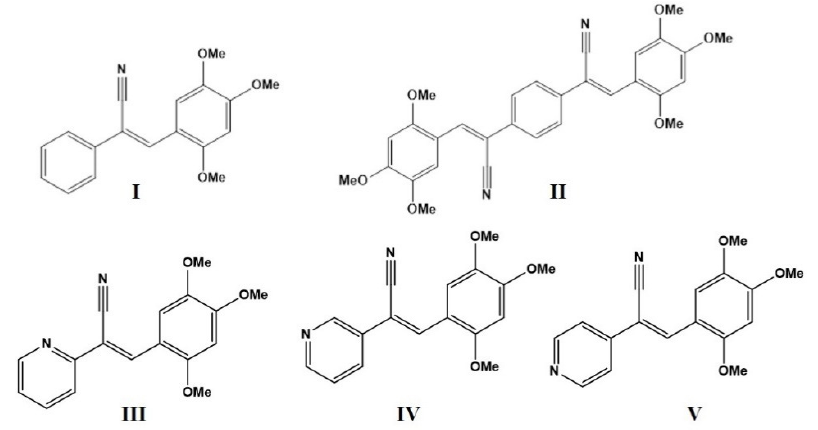
Figure 1. Chemical structures of compounds I – V.